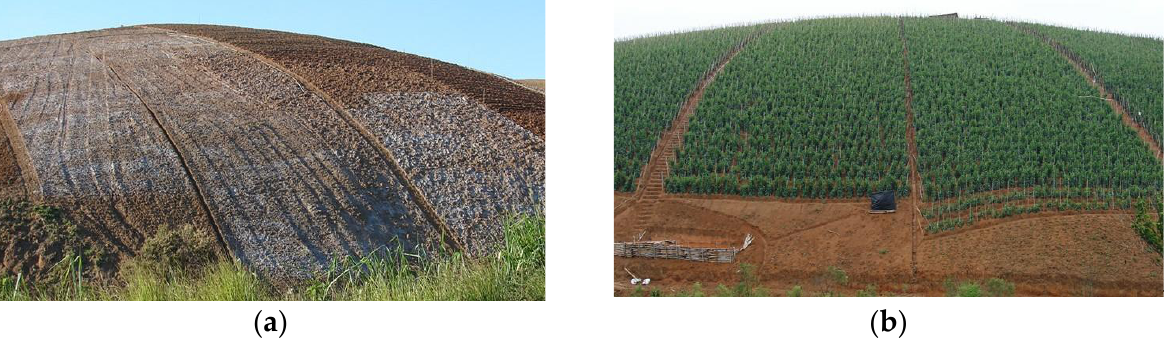
Figure 14. ( a ) Soil preparation for cropping in which use of lime and P fertilizers are the norm [11]. ( b ) Tomatoes in full vegetative stage, with intermediate rows for traffic of people and machinery between plots [11].